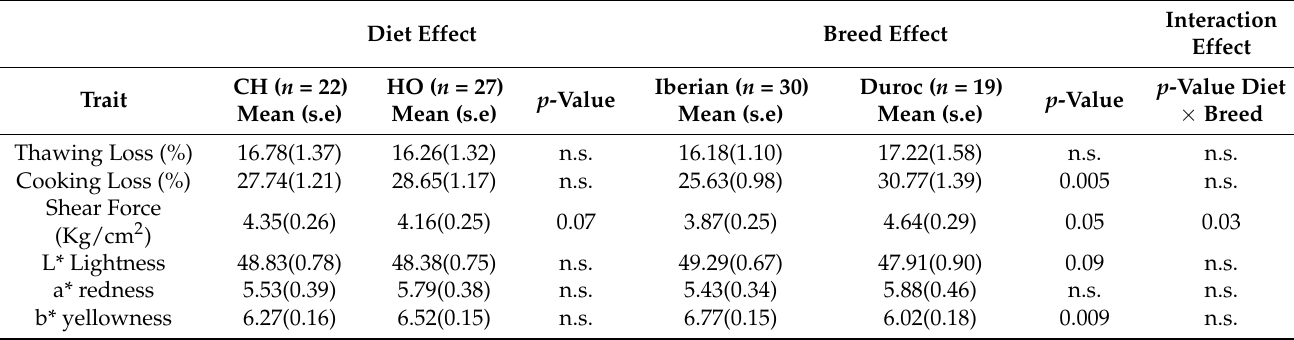
Table 2. Meat quality data recorded in biceps femoris muscle of Iberian and Duroc pigs fed CH and HO diets, at an average LW of 51.2 kg (growing stage).